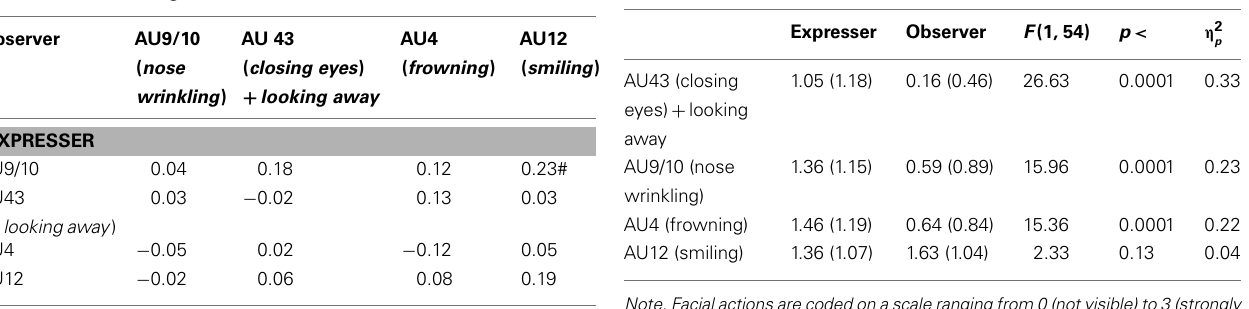
Table 1 | Correlations between facial actions of expresser and observer after the disgust